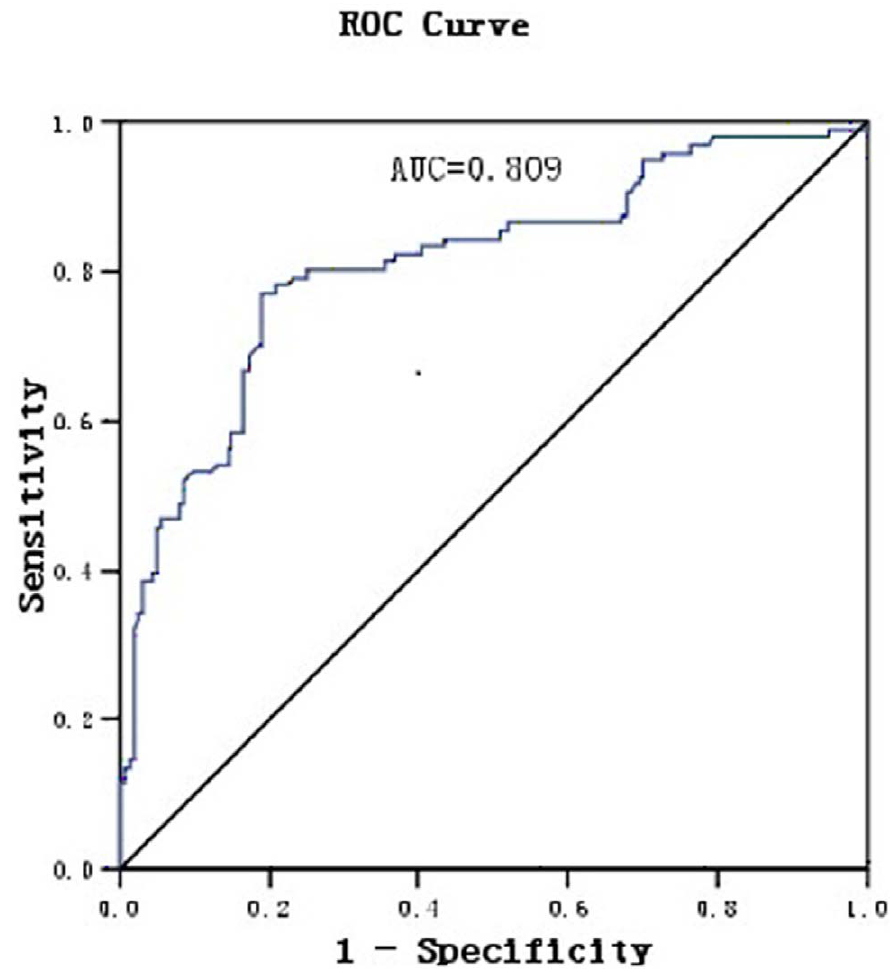
Figure 2. ROC curves for GDF-15 in hypertensive patient with or without LVH.